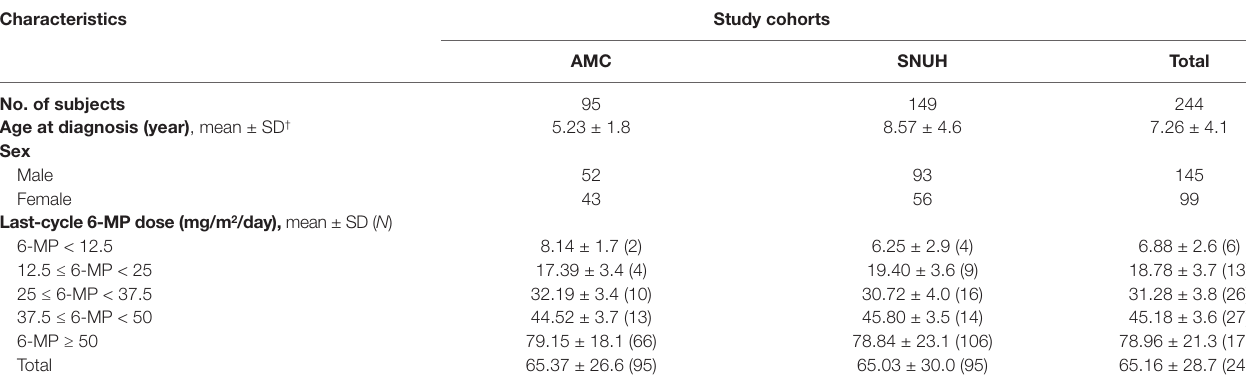
TABLE 1 | Clinical characteristics of study subjects. Characteristics Study